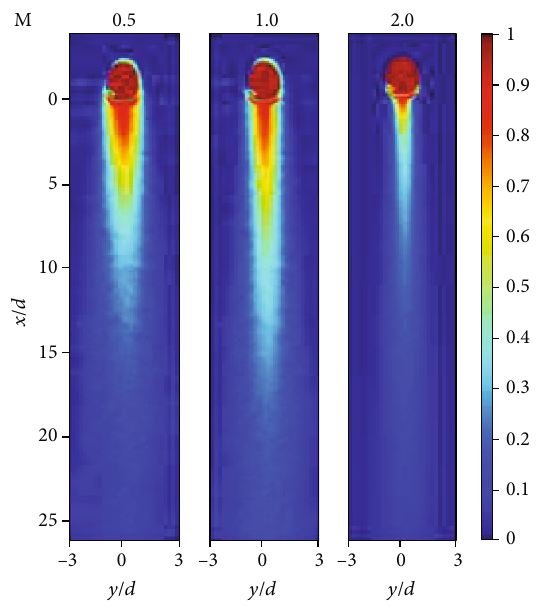
Figure 9: Experimental contours of θ = 7 ° .